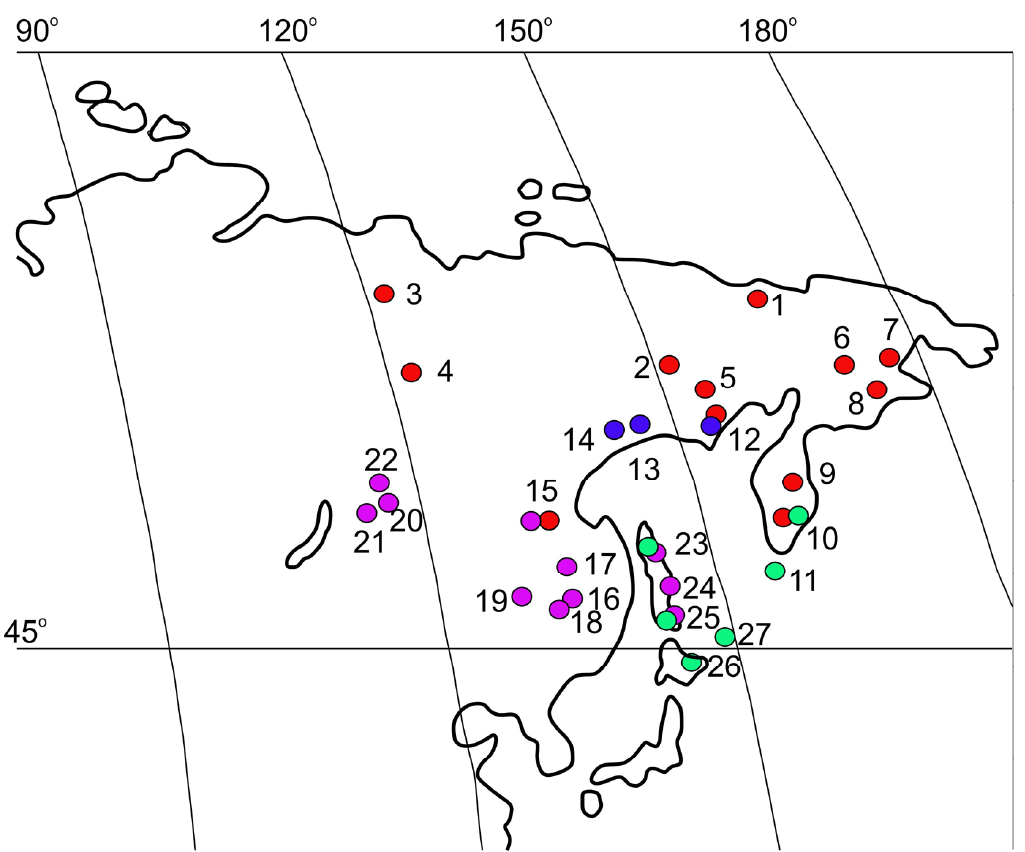
Figure 1. Distribution of Kolhymamnicola snails. Blue circles— K. ochotica , red— K. kolhymensis , violet— K. wasiliewae , green— K. miyadii . ( 1 ) Lower Kolhyma River basin, near Chersky settlement, 68 ◦ 44 (cid:48) N 161 ◦ 21 (cid:48) E (type locality). ( 2 ) Middle Kolhyma River basin, nameless floodplain-thermokarst lake, 66 ◦ 39 (cid:48) N 152 ◦ 35 (cid:48) E. ( 3 ) Lower Lena River basin, 67 ◦ 49 (cid:48) N 123 ◦ 06 (cid:48) E. ( 4 ) Lower Lena River basin, near the confluence of the Vilyui River, 64 ◦ 27 (cid:48) N 126 ◦ 06 (cid:48) E. ( 5 ) Middle Kolhyma River basin,